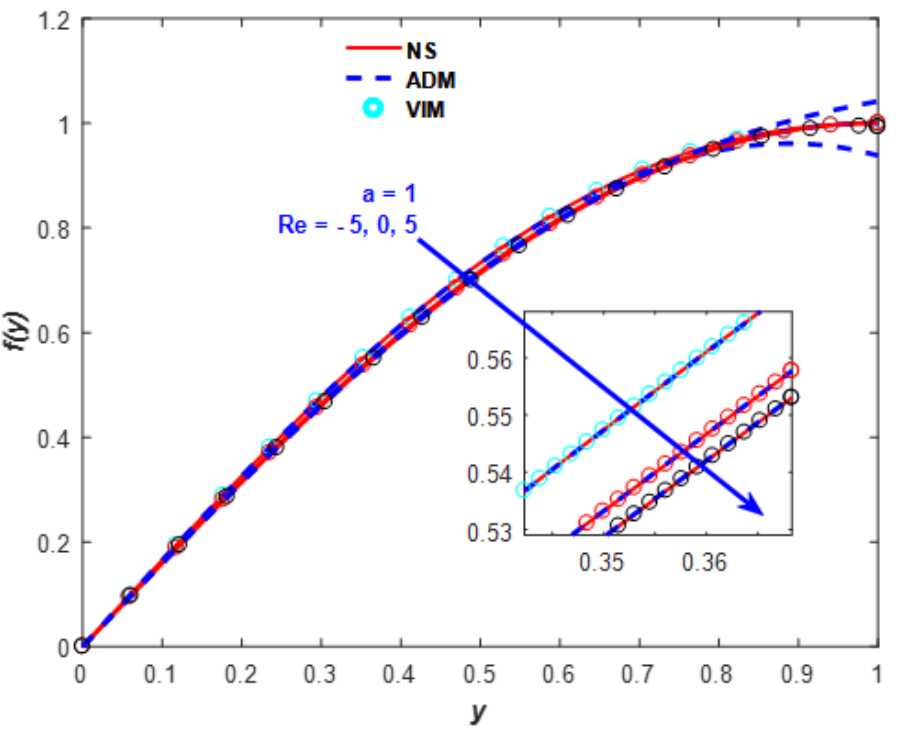
Figure 8. Behavior of f ( y ) with variation of Re simulated by numerical simulation, ADM and VIM.